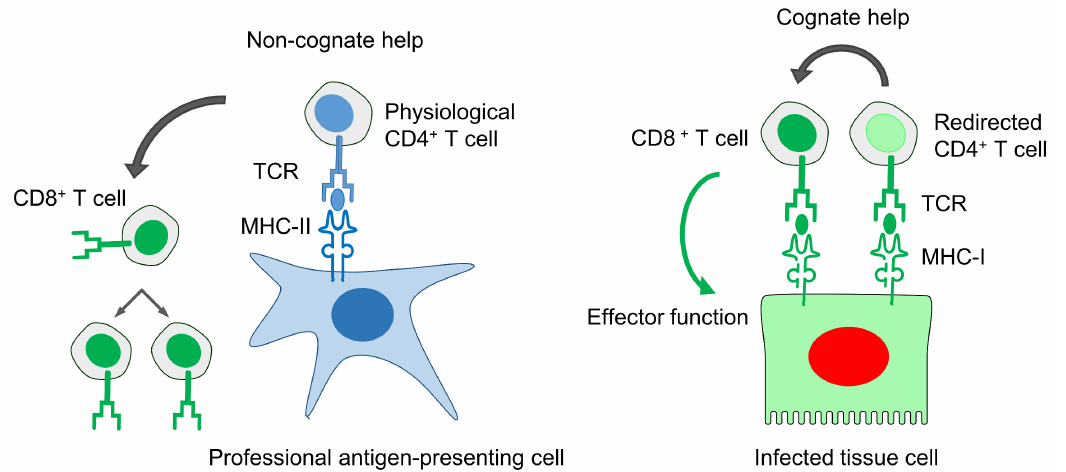
Figure 2. Models of “non-cognate” versus “cognate” help. See the body of the text for explanation. Blue: MHC/HLA-II-restricted. Green: MHC/HLA-I-restricted. Red: Infected. Reproduced, with modification, from Reference [130], Medical Microbiology and Immunology , Springer, 2016.